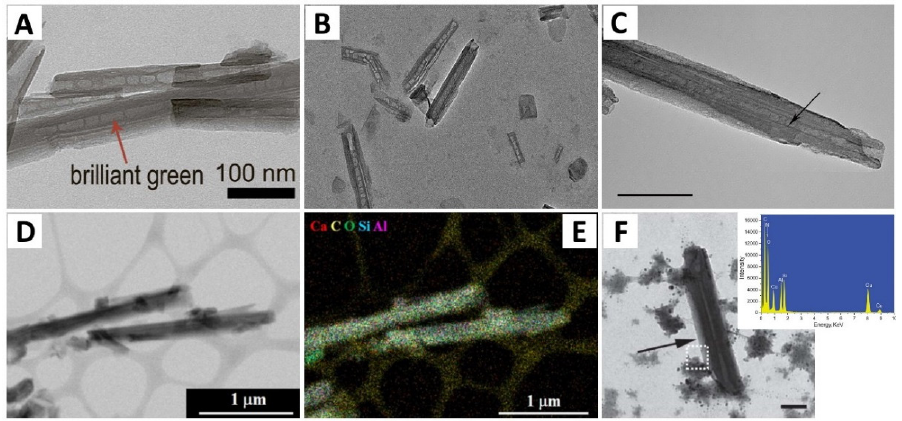
Figure 11. TEM images of HNTs loaded with ( A ) brilliant green. Reproduced from Ref. [137] Copy- right 2015 Dzamukova, Naumenko, Lvov, Fakhrullin, ( B ) norfloxacin. Reproduced with permission from Ref. [106]. Copyright 2020 Elsevier; ( C ) binase. Reproduced from Ref. [138]. Copyright 2017 Khodzhaeva, Makeeva, Ulyanova, Zelenikhin, Evtugyn, Hardt, Rozhina, Lvov, Fakhrullin and Ilin- skaya; ( D ) TEM image and ( E ) EDX elemental mapping of HNTs loaded with calcium alginate Re- printed with permission from Ref. [139]. Copyright 2018 American Chemical Society; ( F ) TEM image of chitosan grafted HNTs and the corresponding EDX spectrum from highlighted zone. Reproduced with permission from Ref. [140]. Copyright 2013 Royal Society of Chemistry.